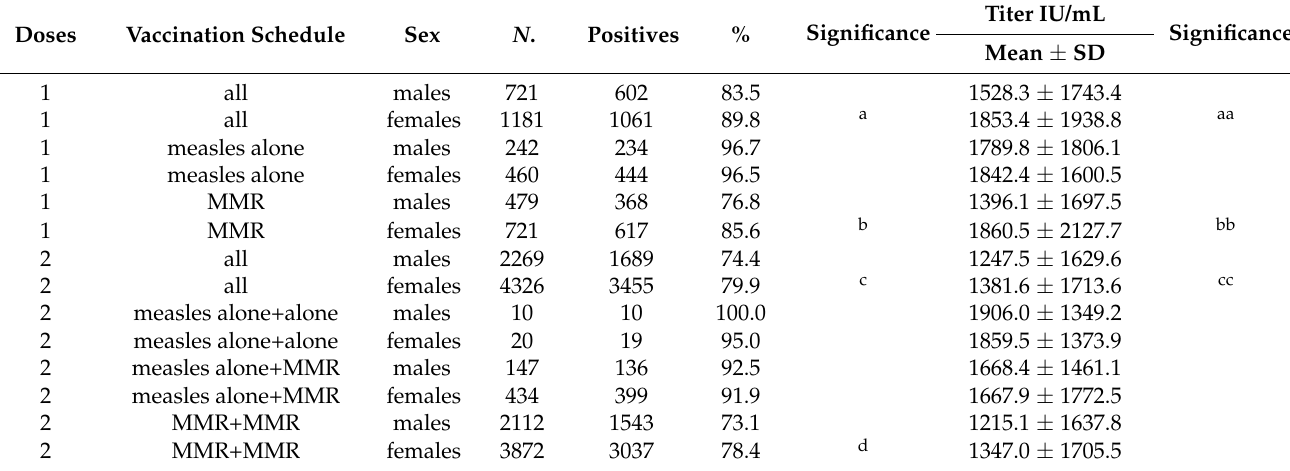
Table 3. Percentage of positive students and antibody titer according to sex and vaccination schedule.